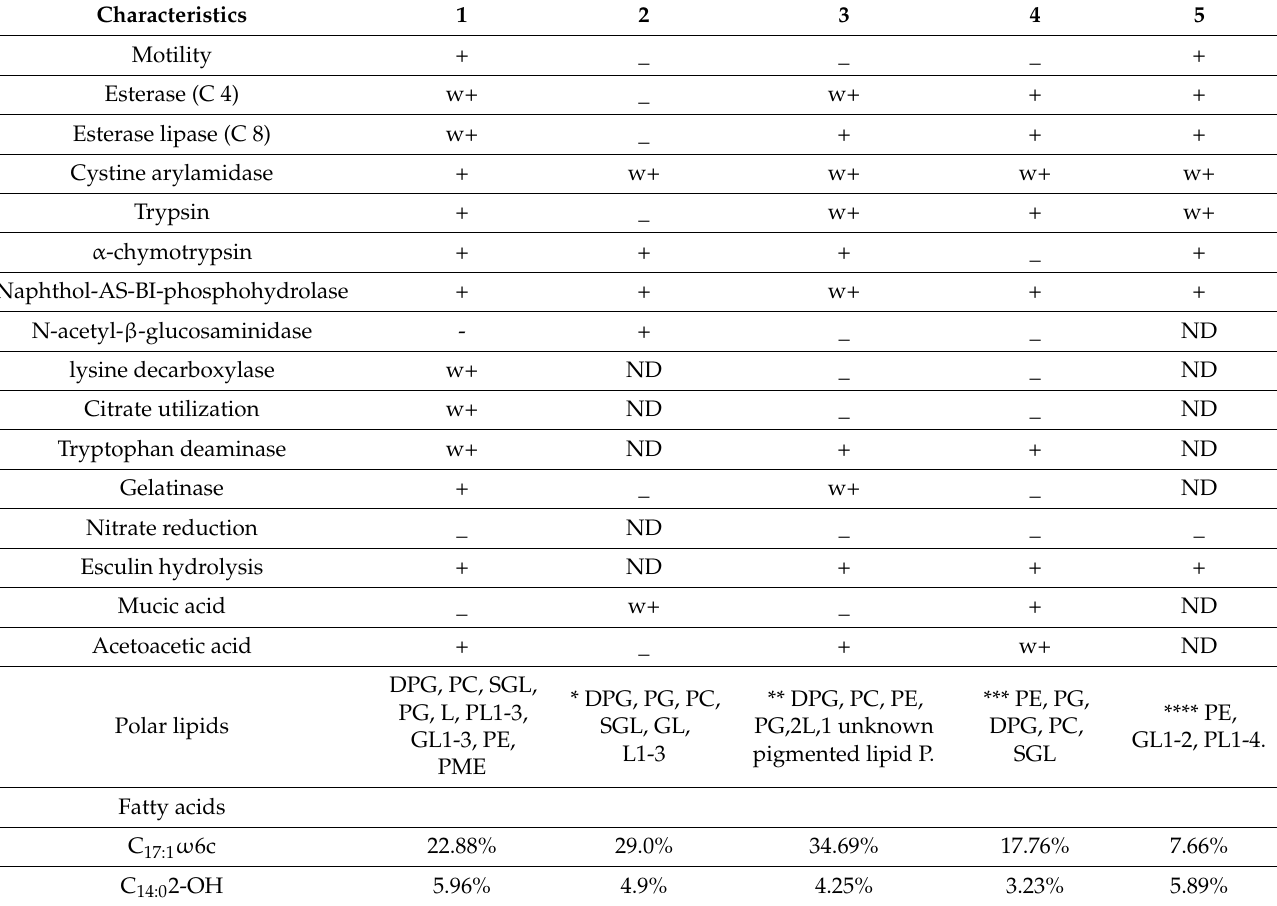
Table 4. Differential characteristics of strain NZ-12B T and closely related type